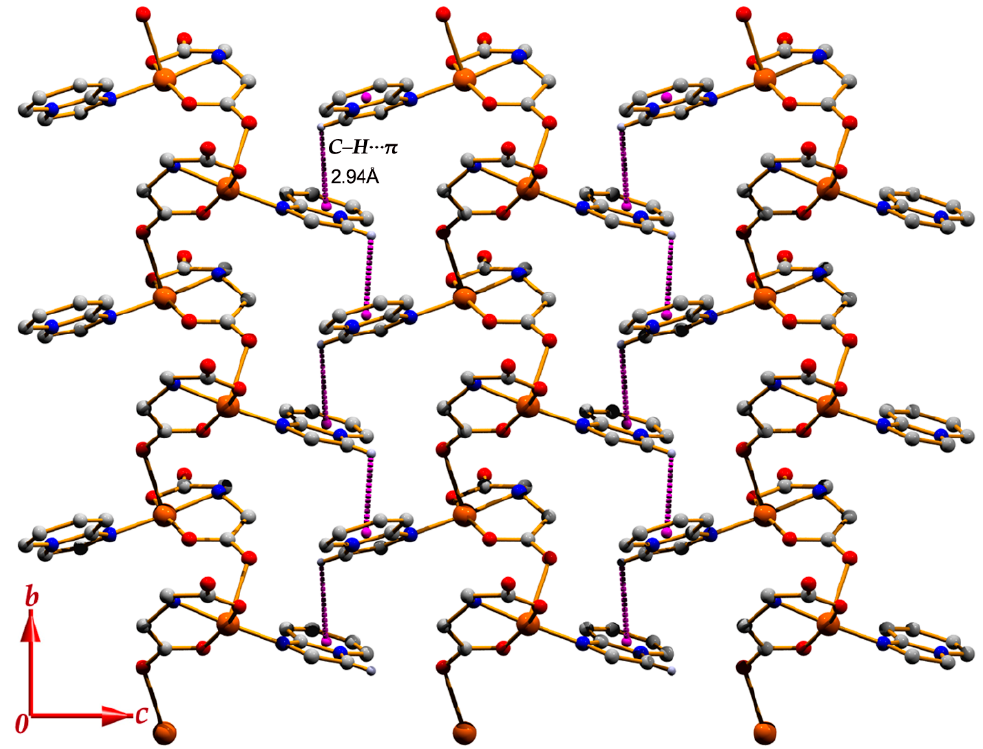
Figure 4. Formation of supramolecular layer network in (011) plane.